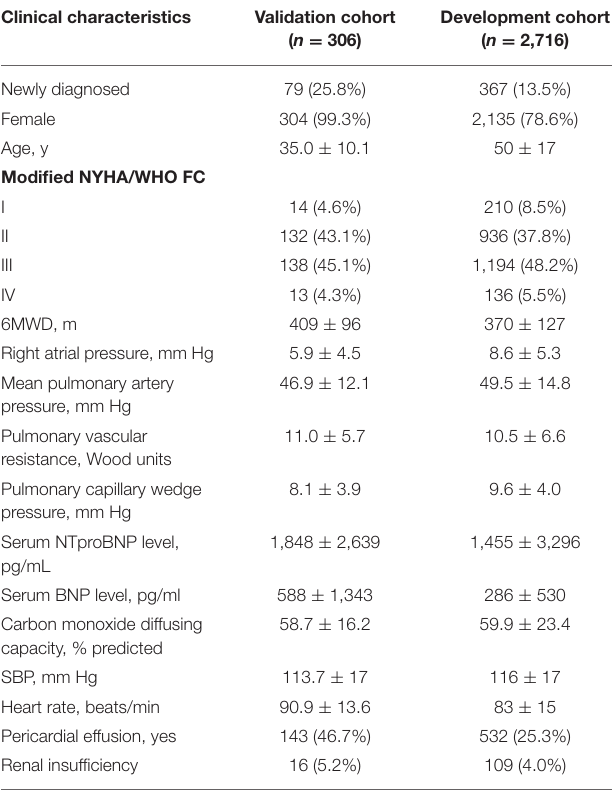
TABLE 2 | Baseline clinical characteristics of the validation